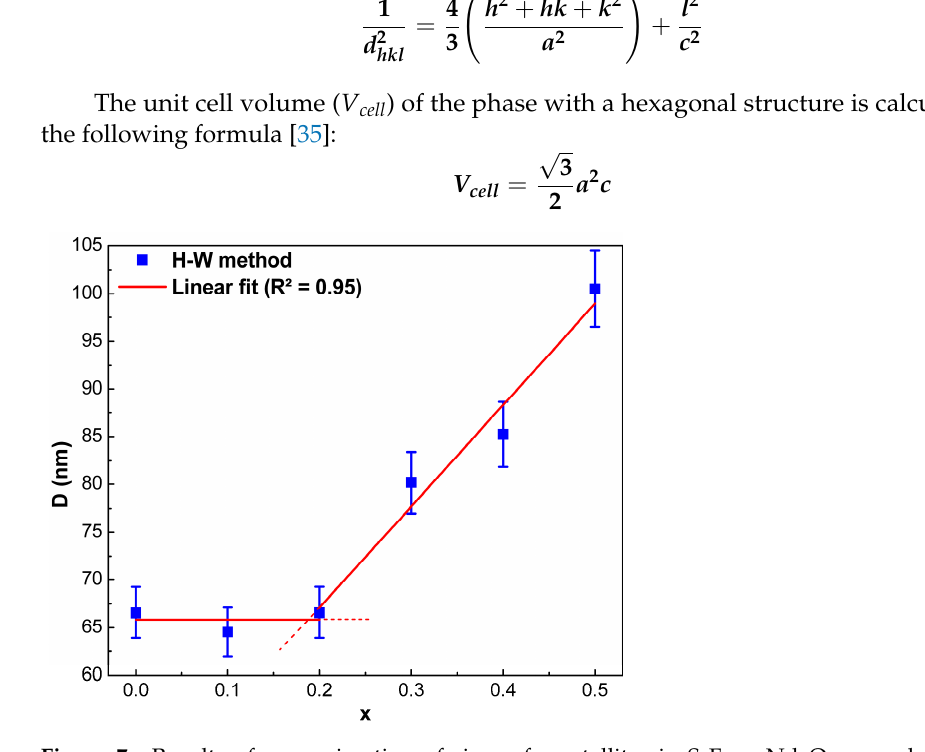
Figure 7. Results of approximation of sizes of crystallites in SrFe 12-x Nd x O 19 powders, where 0 ≤ x ≤ 0.5, obtained by the Halder–Wagner method as a function of Nd content (x). The lattice parameters ( a , c ), the ratio ( c/a ), as well as the unit cell volumes of the phase with the SrFe 12 O 19 hexaferrite structure in the synthesized powders SrFe 12-x Nd x O 19 , where 0 ≤ x ≤ 0.5, calculated using the Formula (15) and (16) are shown in Table 3. At the same time, the most intense main lines, according to which the calculation was carried out, are shown in Figure 2b. Table 3. Calculated values of lattice parameters ( a , c ), ratios ( c / a ), and volumes of unit cell phases with SrFe 12 O 19 hexaferrite structure in synthesized powders SrFe 12-x Nd x O 19 , where 0 ≤ x ≤